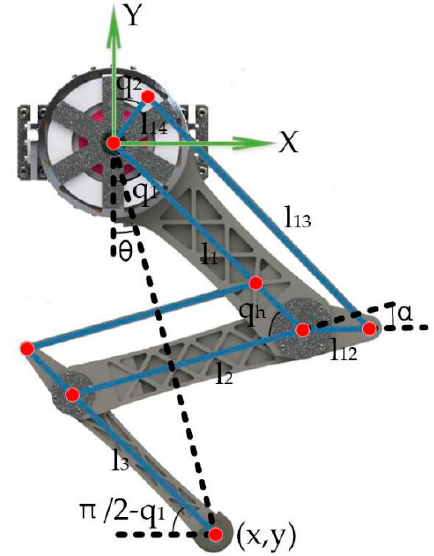
Figure 10. Inverse kinematics model of the leg.